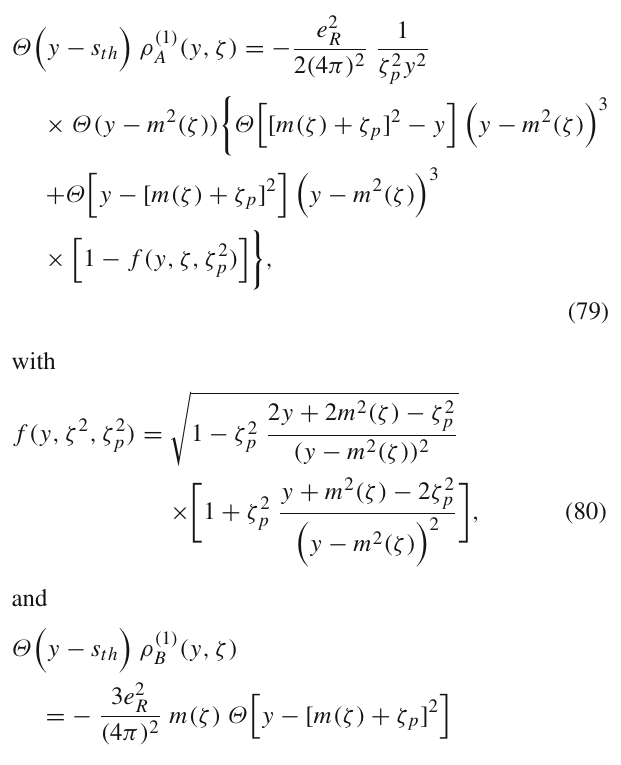
ω = m 2 (ζ) . Upper panel the vec- th = 0 . 04 m p